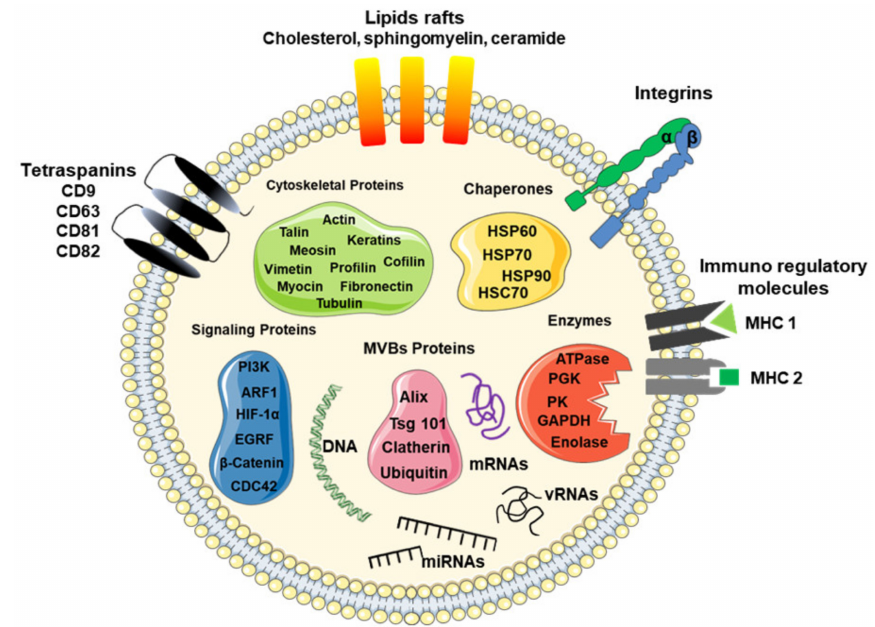
Figure 1. Schematic model of a typical exosome. The model shows a nanosized membrane-bound extracellular vesicle, with a diameter between 30 and 200 nm, expressing several proteins as a marker for exosomes, including tetraspanins (CD9, CD63, and CD81), Alix, Tsg101, and heat shock proteins (HSP-60, -70, and -90), as well as surface proteins, such as tetraspanins, integrins, immunoregulatory proteins (MHC-I and MHC-II), cytoskeletal proteins, signaling proteins, enzymes, and nucleic acids, such as coding RNAs (mRNAs) and non-coding RNAs (miRNAs and lncRNAs). Exosomes were discovered in 1983 [19–21]. However, they were initially proposed as cellular waste resulting from cell damage or by-products of cell homeostasis [20,22].